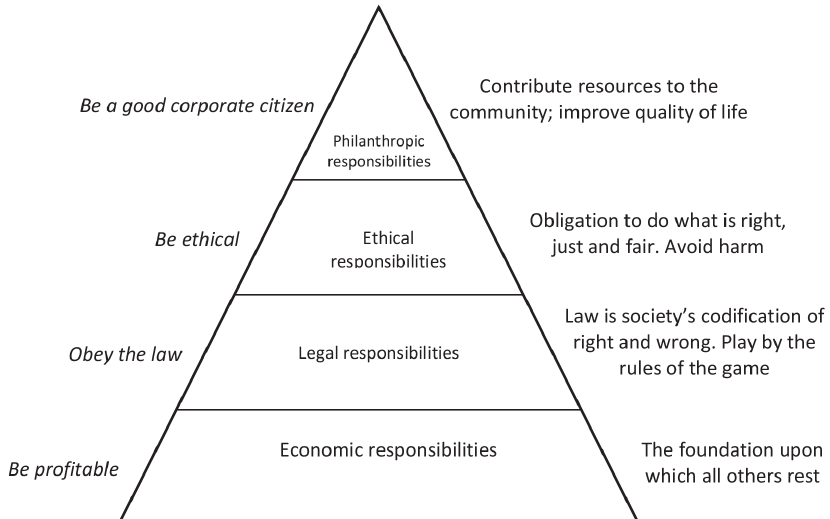
Fig. 1. Carroll’s (1991) pyramid of corporate social responsibility